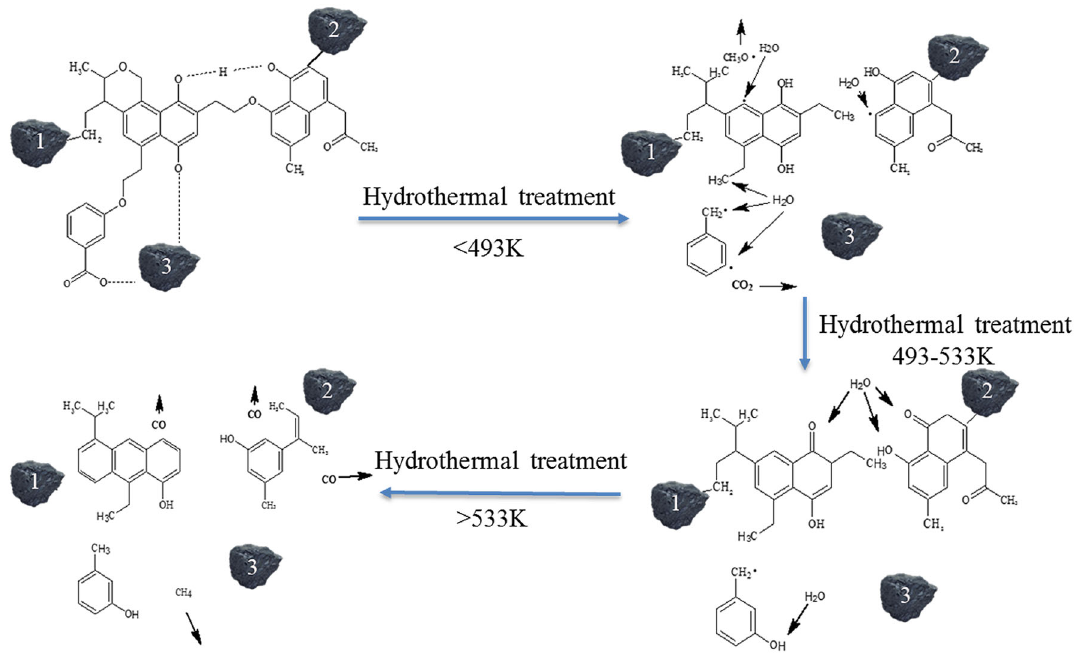
Fig. 9 Schematic of the structural evolution of IM lignite during hydrothermal